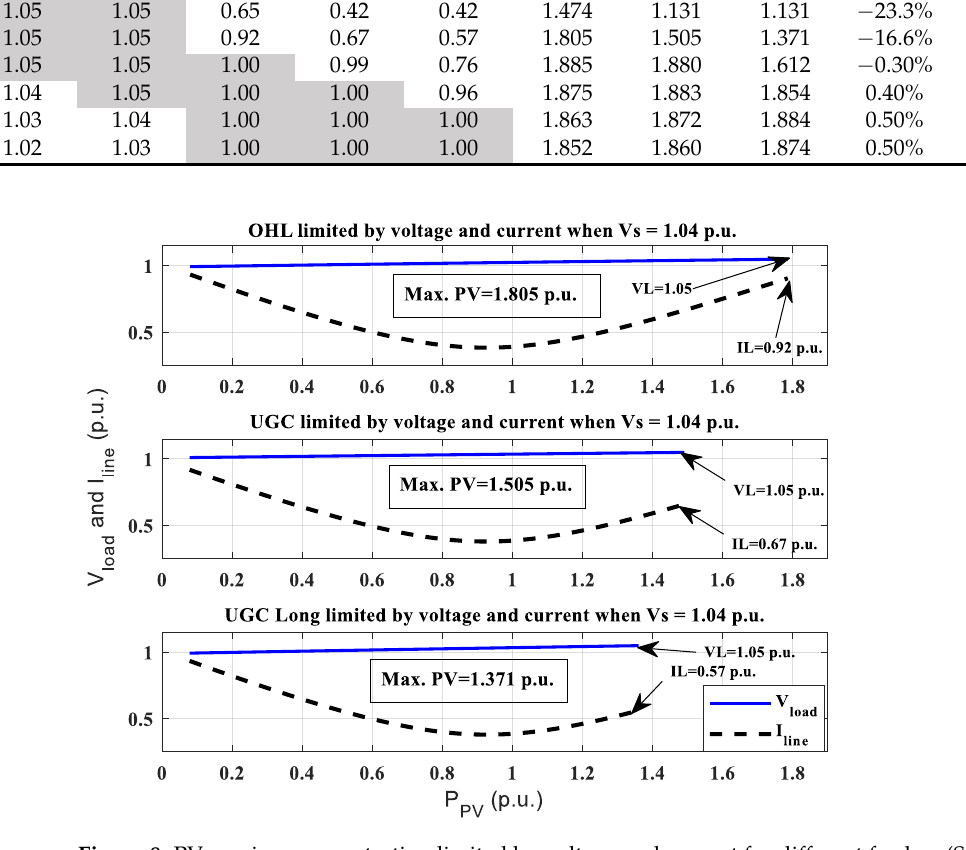
Table 4 shows the maximum PV penetration limited by both voltage and current for different feeders and different substation voltages. As shown in Table 4, for high substa- tion voltages ( 𝑉 𝑆 = 1.05 or 1.04 p. u. ), the load bus voltage is the limiting factor for the three feeder types (Figure 8). On the other side, for low substation voltages ( 𝑉 𝑆 = 1.01 or 1 p.u. ), the feeder ampacity is the limiting factor. For 𝑉 𝑆 = 1.03 p. u. , the maximum PV Figure 7. PV maximum penetration limited by voltage only for different feeders Figure 7. PV maximum penetration limited by voltage only for different feeders ( Substation voltage 𝑉 𝑆 —1 p.u.) . penetration is limited by feeder ampacity of the OHL while it is limited by bus voltage for (Substation voltage V S 1 p.u.). both UGC and UGCL. If 𝑉 𝑆 = 1.02 p. u. , the maximum PV penetration is limited by feeder current for both the OHL and the UGC while limited by voltage for the UGCL. Table 4. Changing the substation voltage ( V S ) for the different feeders (limited by both voltage and current). Table 4. Changing the substation voltage ( 𝑉 S ) for the different feeders (limited by both voltage and current). V L V S . 𝐕 𝐋 (p.u.) 𝐕 𝐒 . (p.u.) (p.u) (p.u) 1.04